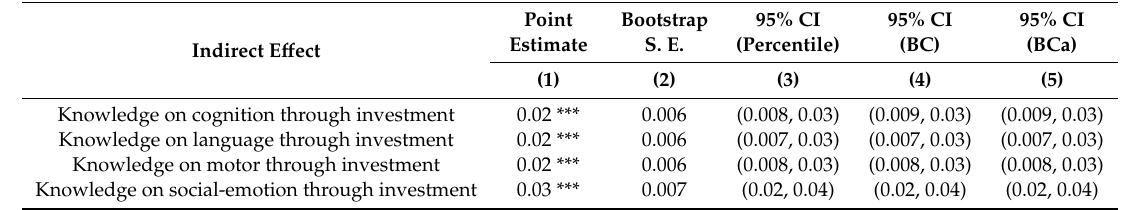
Table 3. Estimates of the indirect e ff ects of parenting knowledge on development outcomes through parental investments.